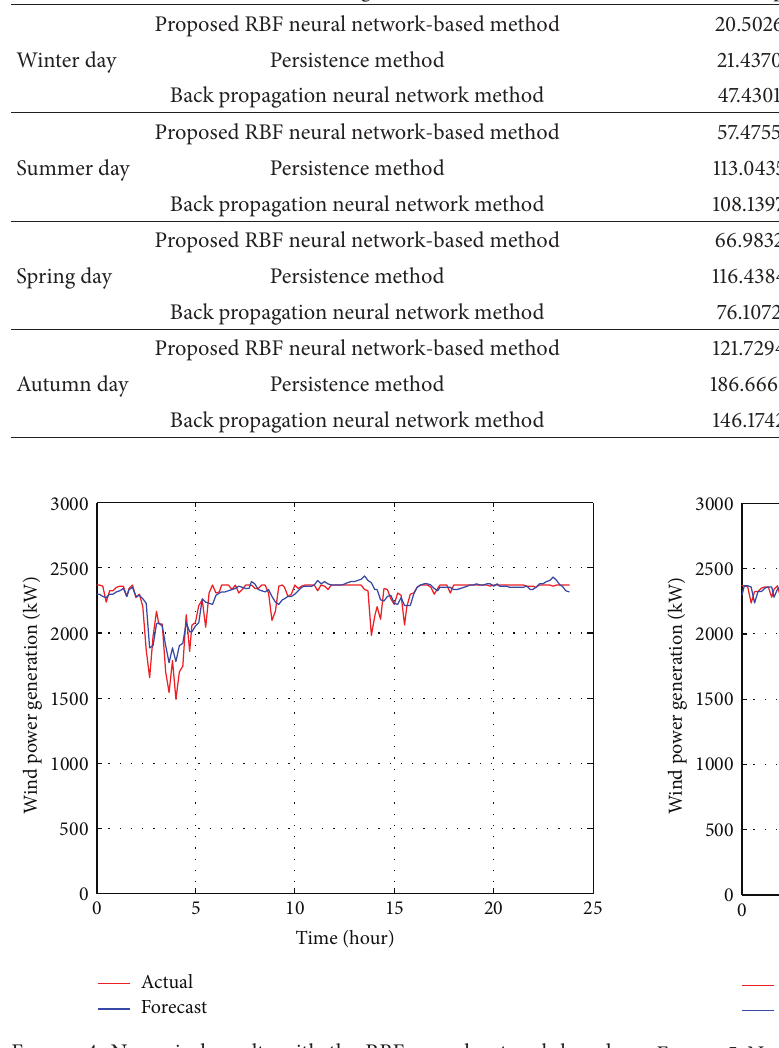
Figure 5: Numerical results with the persistence method for typical winter